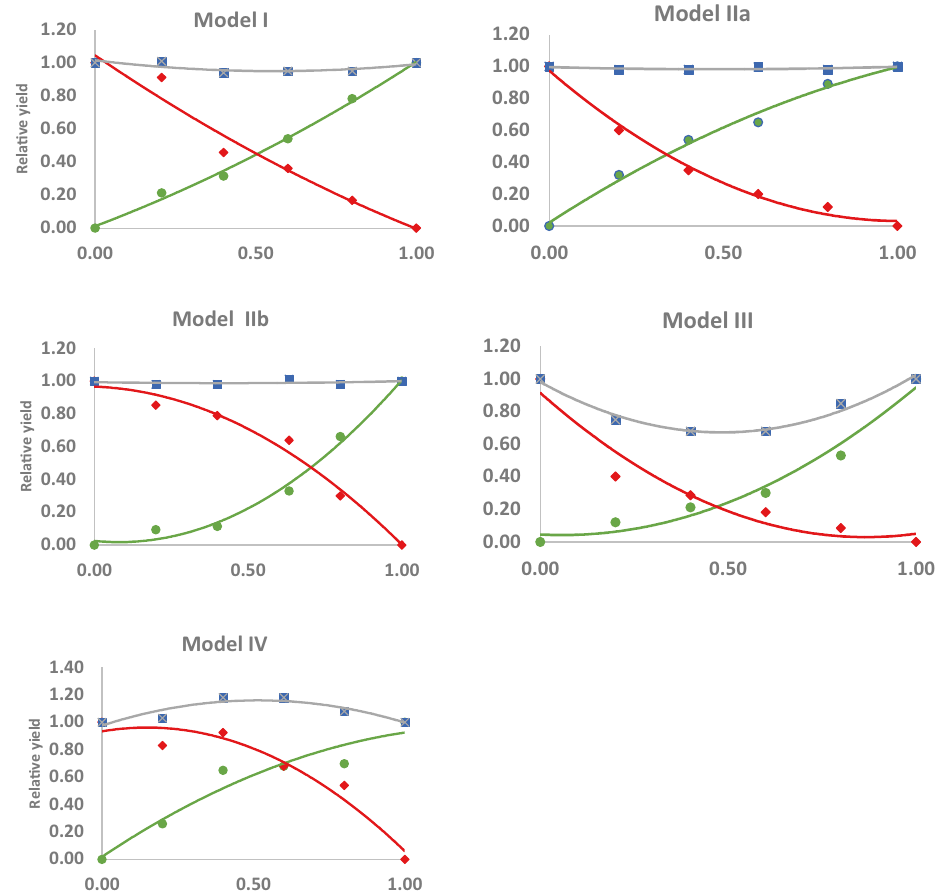
Figure 4. The models of competition between winter wheat (W) and blackgrass (B) for the replacement series experiments. The vertical axis represents relative values of a grain number or biomass, whereas the horizontal axis represents the proportion (0 to 1) of species in a mixture. Legend: green line—B; red line—W, grey line—B +